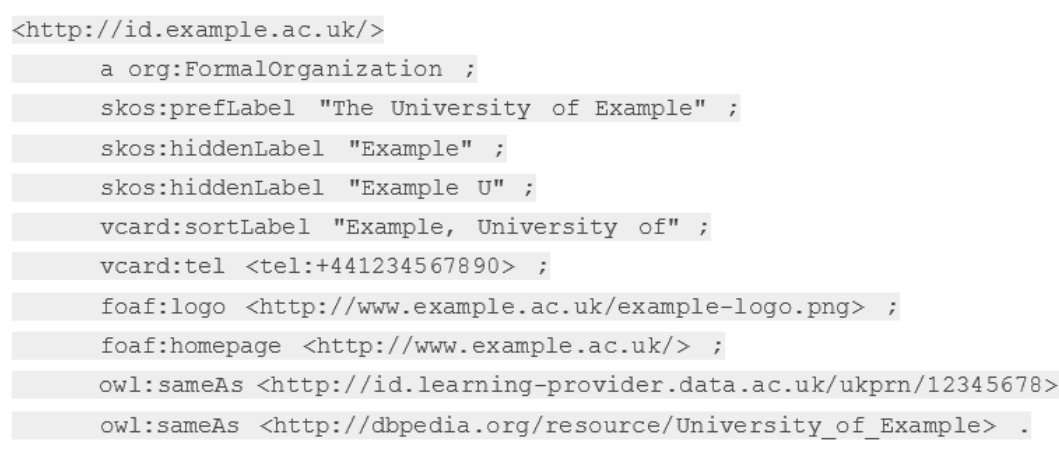
Figure 3. OPD Basic core structure.